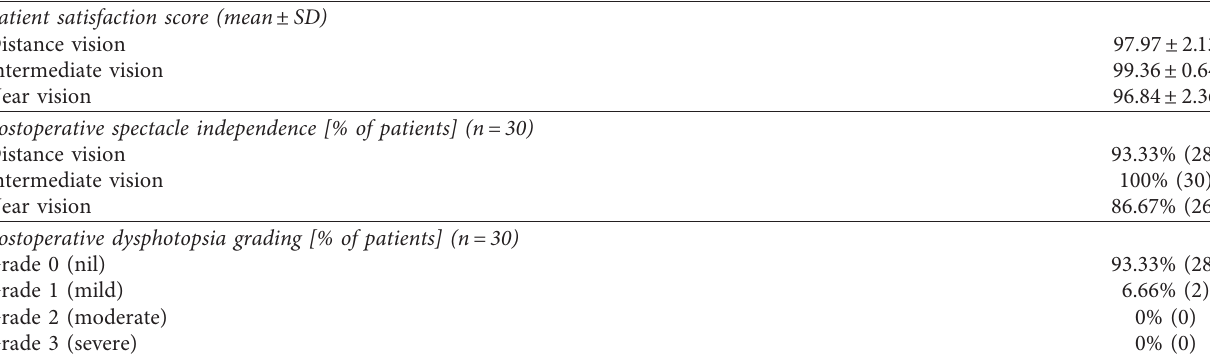
Table 4: Postoperative patient satisfaction score and dysphotopsia